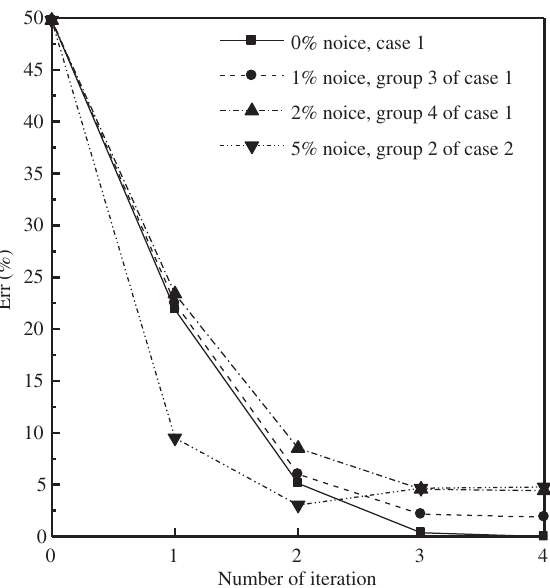
Figure 5: Convergence rate in the identification process of a square FGM plane structure with linear material